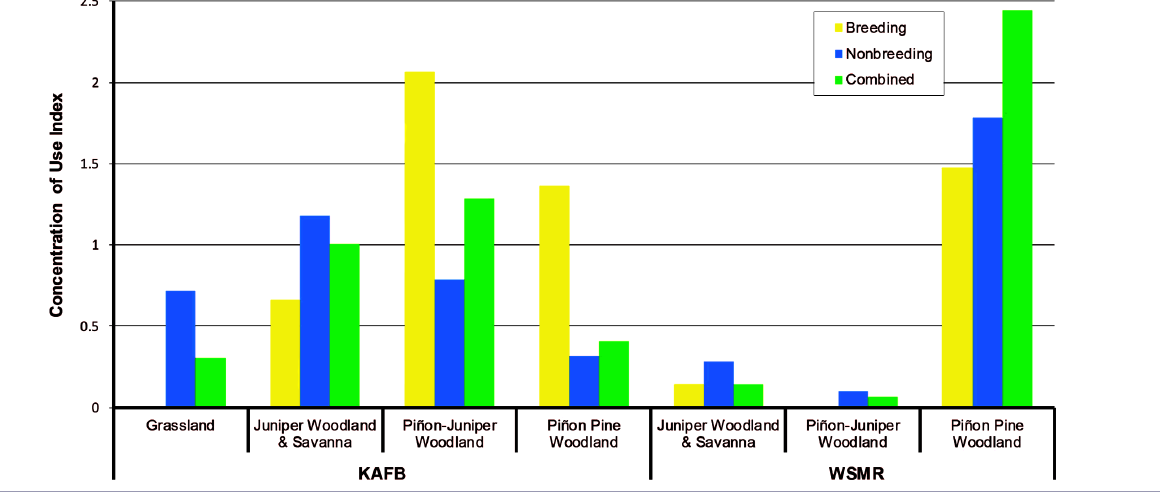
Fig. 4 . Concentration of use (CU) by Pinyon Jays ( Gymnorhinus cyanocephalus ) in breeding, nonbreeding, and combined season home ranges at Kirtland Air Force Base and White Sands Missile Range. CU = probability of use for a land cover type in the home range divided by the occurrence of that land cover in the home range. CUs for land cover types composing > 5% of home range polygons are